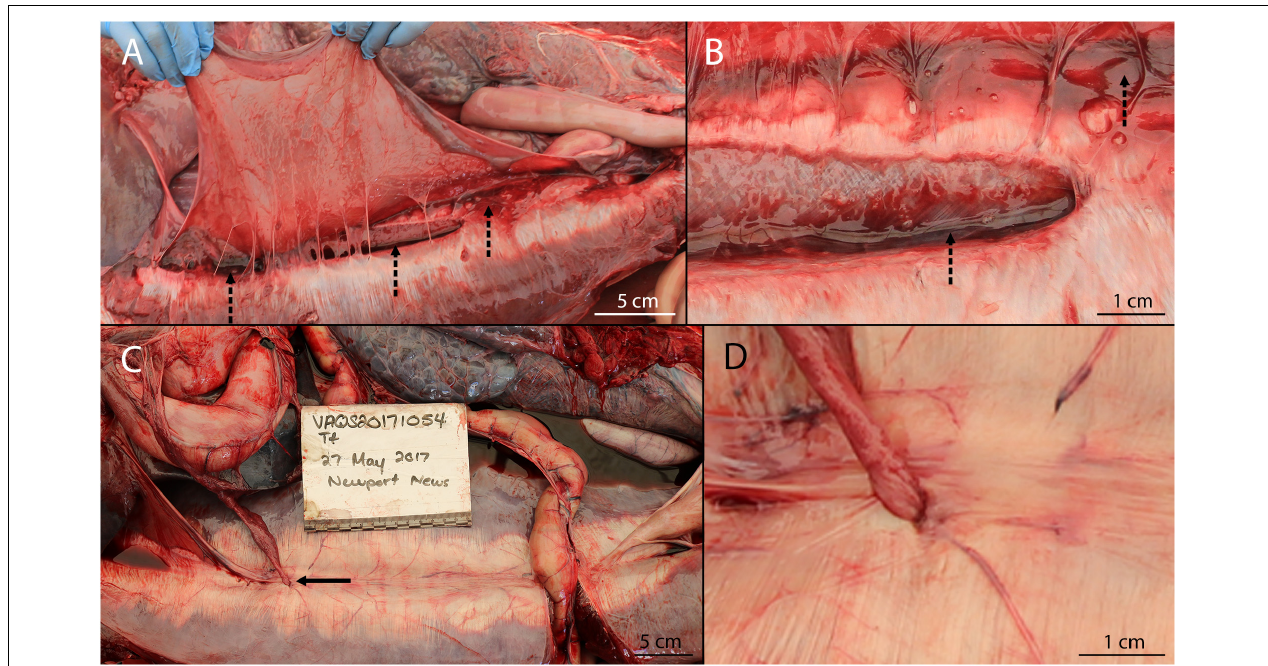
FIGURE 2 | Abdominal lesions in bycaught bottlenose dolphins. (A) Separation of the rectus abdominis muscles with intact peritoneum reflected back. Emissary blood vessels from cranial epigastric artery and veins visible as long strands. Note the hemorrhagic edema present along the length of the separation (dotted arrows). (B) Detail of caudal margin of rectus abdominis separation showing hemorrhagic edema (dotted arrows) and irregular margins consistent with tearing. (C) Omental hernia through rectus sheath (solid arrow). This hernia is chronic, however, gross presentation of acute hernias did not differ. Note that the caudal incision (to the right of the image) with the intestinal loop is an artifact of dissection. (D) Detail of omental hernia. Note the emissary vessel emanating from the hernia location and an additional emissary vessel to the right of the hernia.